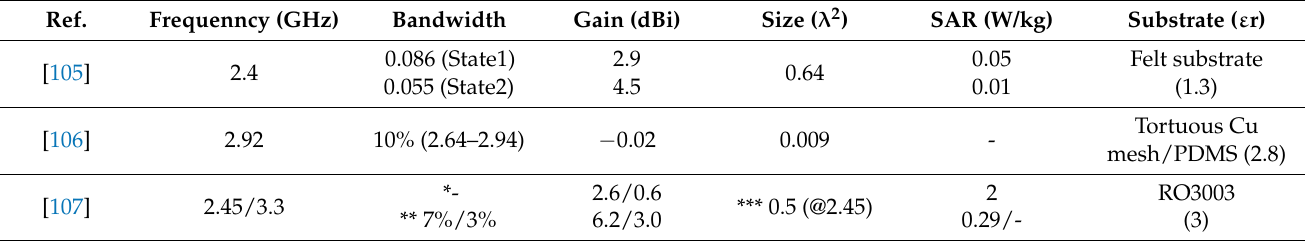
Table 3. Performances among the reconfigurable wearable antennas with metamaterials. Ref.